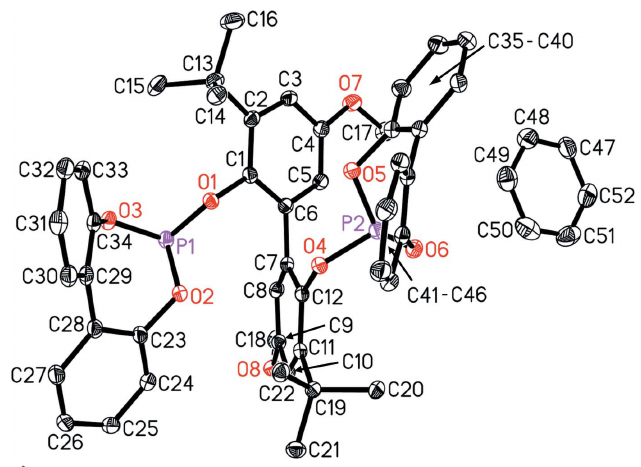
Figure 1 The molecular structure of the title compound with displacement ellipsoids drawn at the 30% probability level. Hydrogen atoms are omitted for